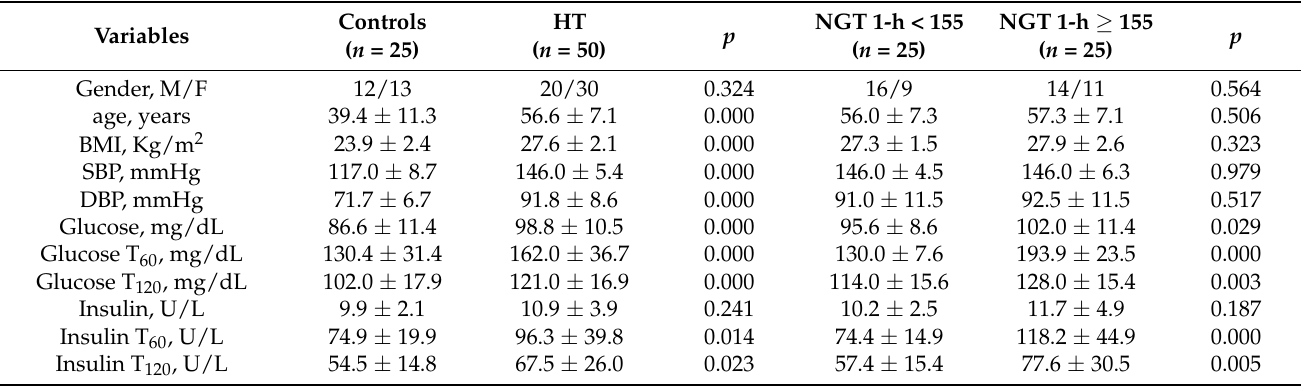
Table 1. Anthropometric, biochemical, and hemodynamic characteristics of the whole study popula- tion and of the two groups of hypertensive patients stratified by 1-h post-load plasma